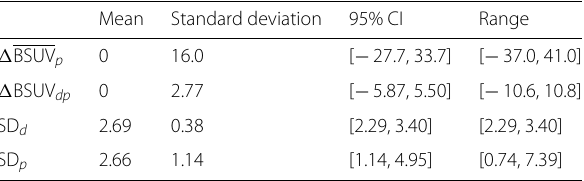
Table 2 Intersubject and interobserver variability of BSUV described by the quantities defined in Eqs. 1–4 (at the stated accuracy level, RMS of (cid:2) BSUV dp according to Eq. 2 is identical to the standard